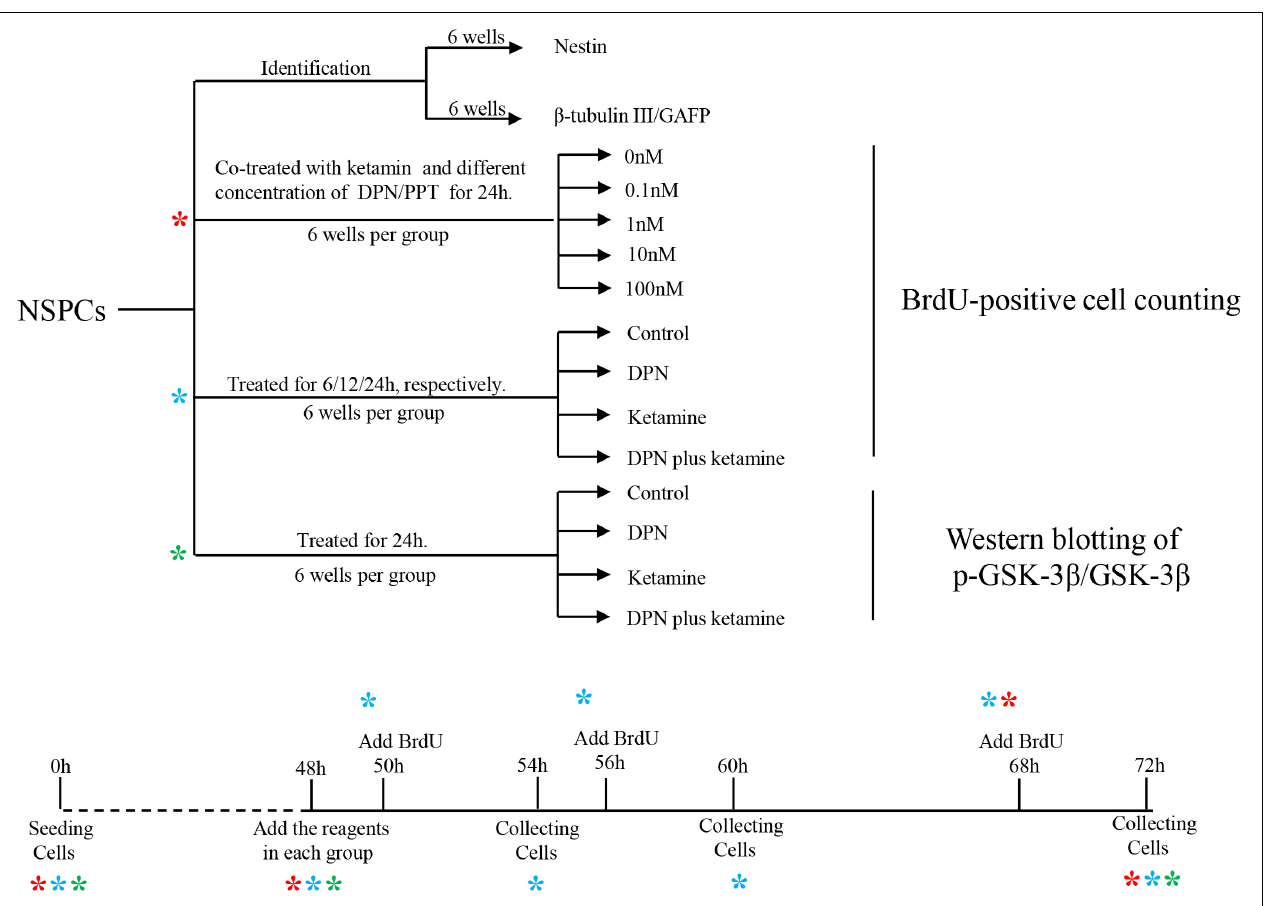
FIGURE 1 | Graphic illustration of experimental design. NSPCs, neural stem/progenitor cells. *indicates experiment process of cells